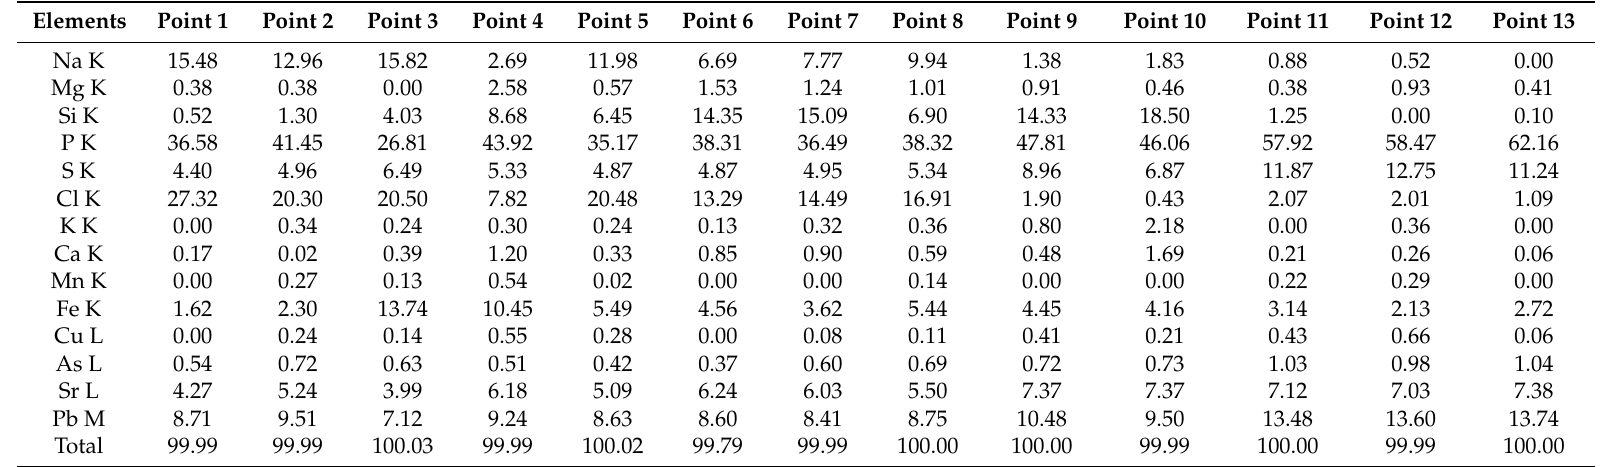
Table 2. Scanning electron microscopy (SEM) equipped with energy dispersive analyses of oily samples collected from the Atake seashore, showing an abundance of Na, Si, P, S, Cl, Fe, Sr, and Pb (EDS system; Pt coating samples; acc. vol. 15